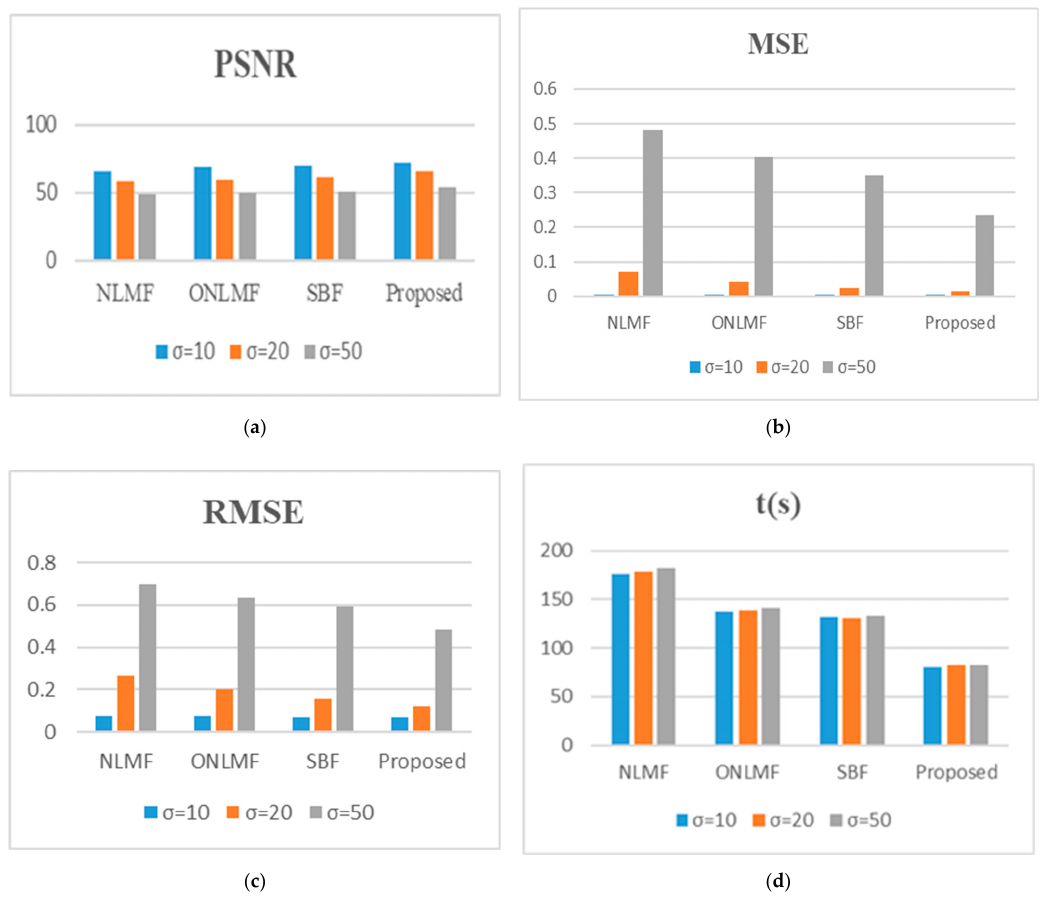
Figure 4. Average ( a ) PSNR; ( b ) MSE; ( c ) RMSE; ( d ) t(s) for several algorithms using public database images. NLMF, non-local means filter; ONLMF, optimized non-local means filter; SBF, switching bilateral filter; PSNR, peak signal-to-noise ratio; MSE, mean squared error; RMSE, root mean squared error; t(s), time in seconds; σ , Gaussian blur standard deviation.